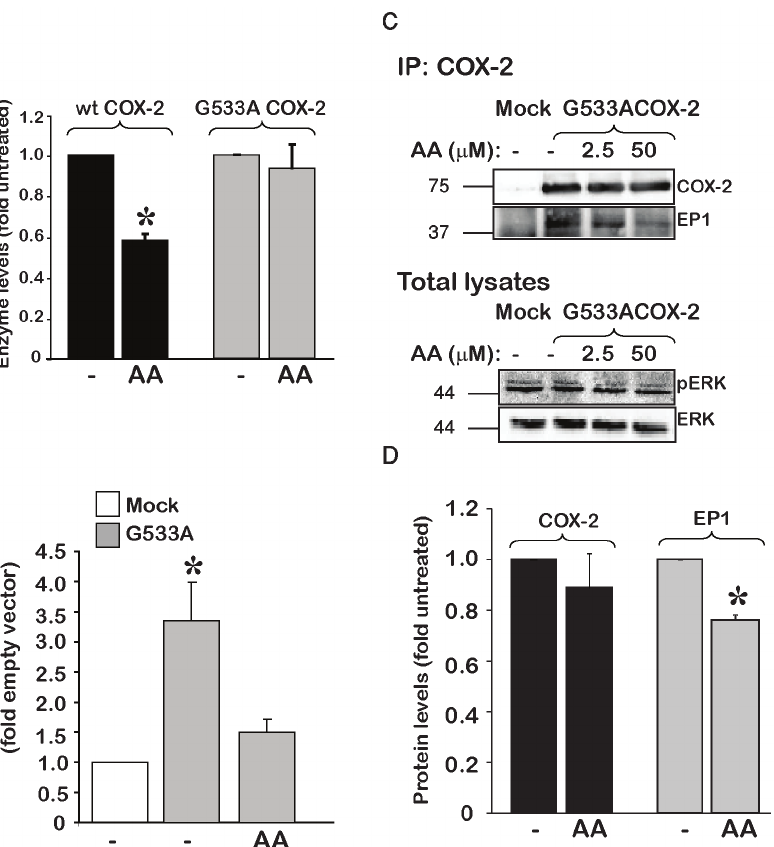
Figure 3. The interaction between COX-2 and EP 1 depends upon the conformation of COX-2. A , Cells were transfected with either wild type (wt) or G533A COX-2 and exposed to 10 m M AA for 19 h. While wt COX-2 levels were lowered in the presence of AA, G533A COX-2 was not affected. n=4 independent experiments *p , 0.05 vs. untreated. B , Summary graph of n=5 independent experiments showing a reduction in the levels of EP 1 co-immunoprecipitated with COX-2 following treatment with AA. *p , 0.05 vs. Mock transfection. HEK 293 cells, transfected with mock or G533A COX-2 were treated with either vehicle (ethanol) or AA (50 m M) for 15 min. Blots were probed for COX-2 and EP 1 . C , Representative immunoblot of n=3 independent experiments depicting the dose-dependent effect of AA on the interaction of G533A COX-2 with EP 1 . Cells were transfected with either mock or G533ACOX-2 DNA, and 16 h post-transfection treated with 2.5 or 50 m M AA for 15 min prior to immunoprecipitation. Immunoprecipitate were probed for COX-2 and EP 1 levels. Total lysates from the same samples were probed first for phosho-ERK followed by total ERK levels. D , prolonged exposure to AA, does not affect G533A COX-2 but reduces EP 1 levels. Cells overexpressing G533A COX-2 were treated with 10 m M AA for 1.5–2 h, samples were collected and probed for levels of COX-2 and EP 1 . n=3 independent experiments, *p , 0.05 vs. untreated.